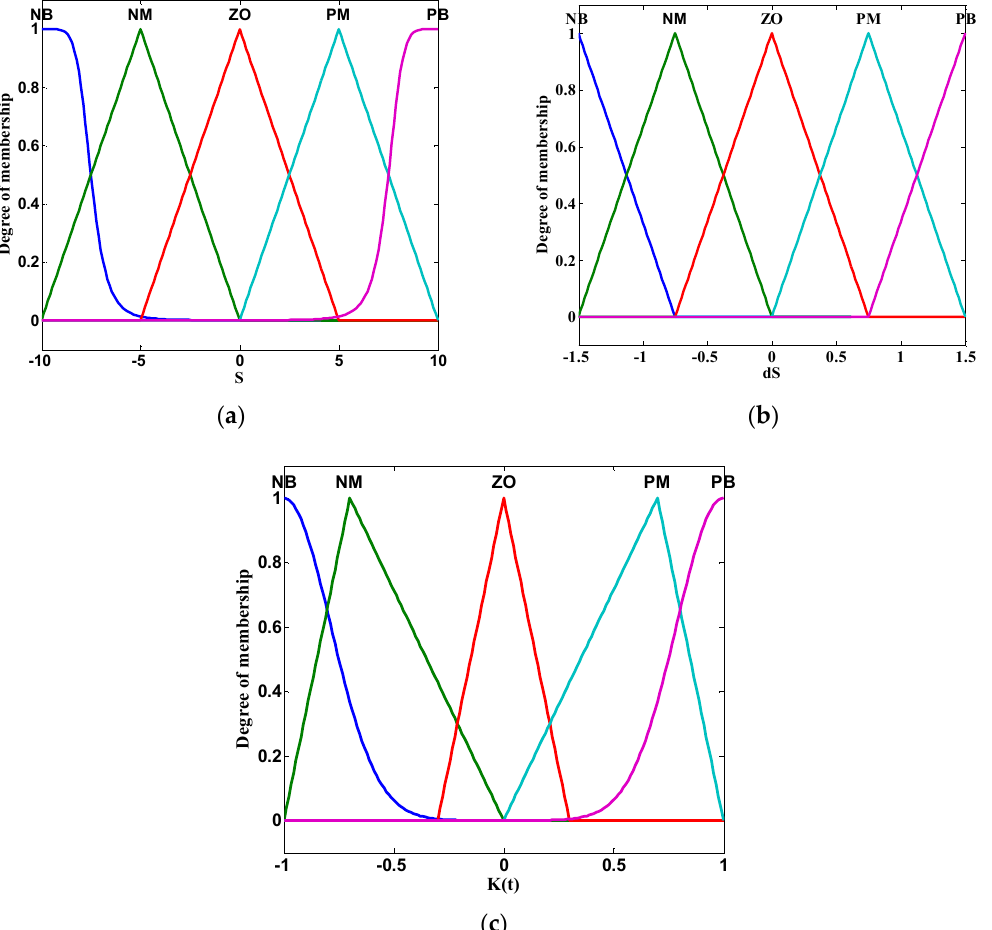
( )  K t . Figure 3. The input / output of the fuzzy system. ( a ) input s , ( b ) input . s , ( c ) output K ( t ) . , ( c ) output